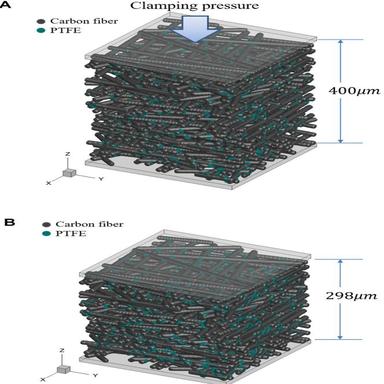
Fibrous structural images of 50 PTLs (a) before and (b) after a stacking pressure of 1 MPa was applied.